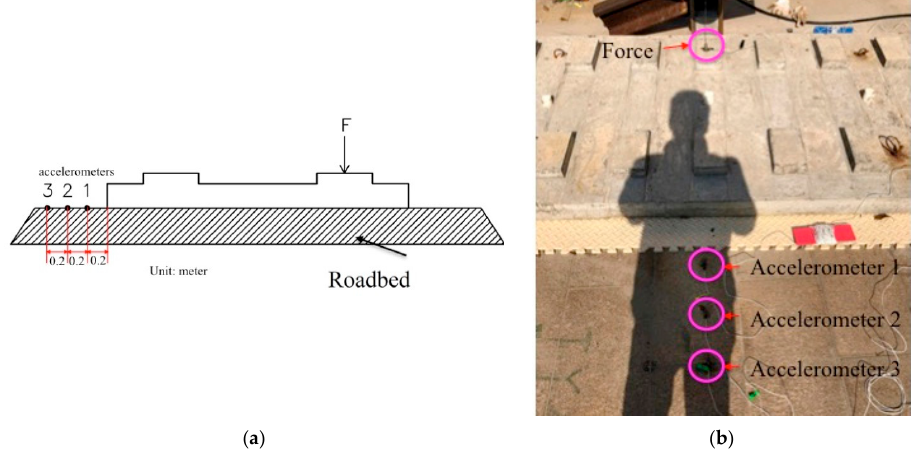
Figure 10. ( a ) The diagram for the testing points distribution (unit: m); ( b ) Testing instrumentation.